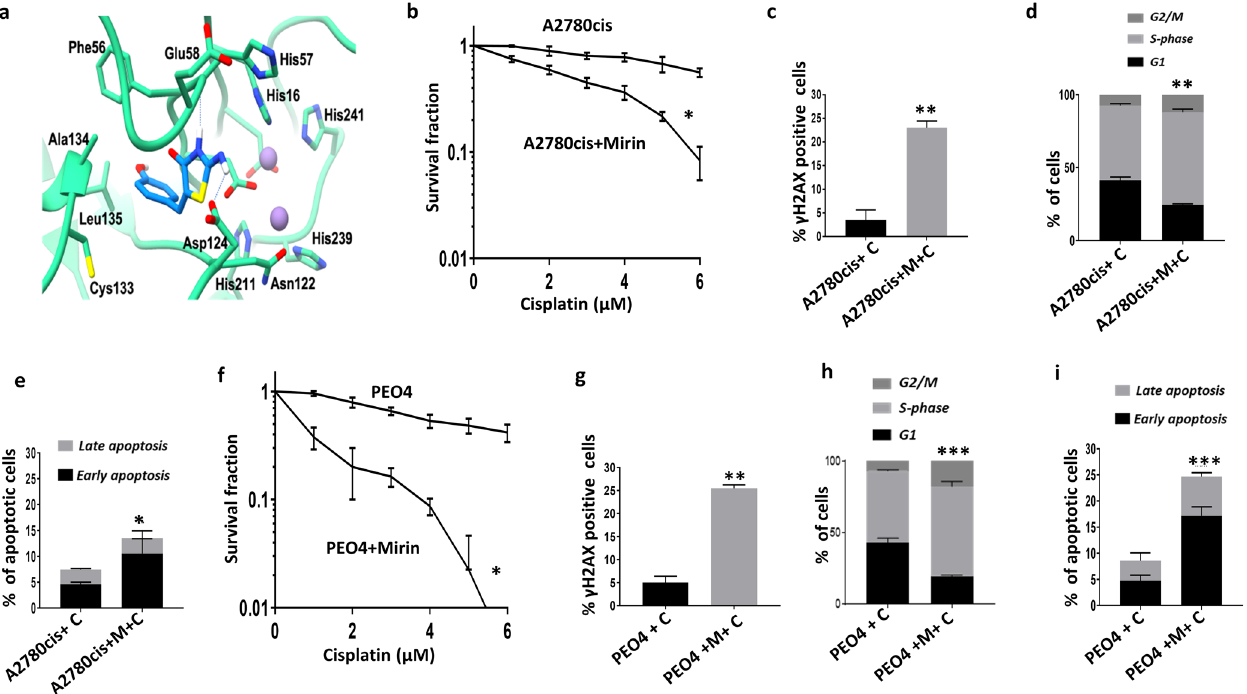
Fig. 3 MRE11 blockade with Mirin and cisplatin sensitivity in ovarian cancer cells. a Binding pose of Mirin (blue) to Mre11 (green) obtained by molecular docking, suggesting Mirin forms a hydrogen bond to the backbone of Glu58 (dashed line). b Clonogenic survival assay for A2780cis cells untreated and pre -treated with Mirin. c γ H2AX positive cells by fl ow cytometry in A2780cis cells treated with cisplatin alone or treated with Mirin plus cisplatin. d Cell cycle analysis by fl ow cytometry in A2780cis cells treated with cisplatin alone or treated with Mirin plus cisplatin. e AnnexinV analysis for apoptotic cells in A2780cis cells treated with cisplatin alone or treated with Mirin plus cisplatin. Cells were plated overnight then treated with Mirin (10 μ M) for 24 h. The following day cells were treated with 5 μ M cisplatin for another 24 h, then collected for cell cycle analysis or AnnexinV analysis by fl ow cytometry. f Clonogenic survival assay for PEO4 cells untreated and pre-treated with Mirin. g γ H2AX positive cells by fl ow cytometry in PEO4 cells treated with cisplatin alone or treated with Mirin plus cisplatin. h Cell cycle analysis by fl ow cytometry. i AnnexinV analysis for apoptotic cells in PEO4 cells treated with cisplatin alone or treated with Mirin plus cisplatin. Figures are representative of three or more independent experiments. Error bars represent standard error of mean between experiments. The P value was calculated as follow, * p > 0.05, ** p > 0.01 and *** p >